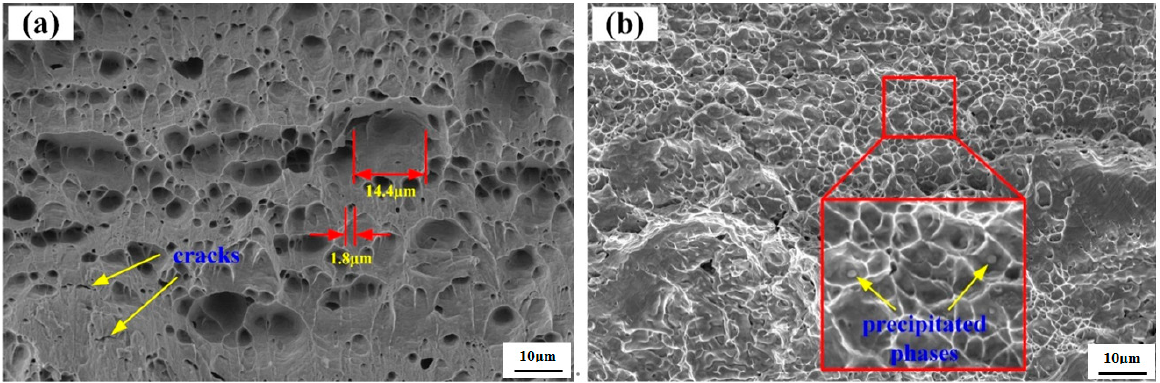
Figure 6. Fractographs of tested samples at room temperature: ( a ) laser welding; ( b ) laser oscillating welding.